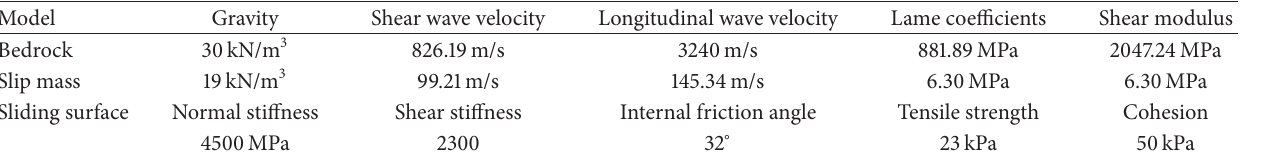
Table 1: Physical and mechanics parameters of bedrock, soil layer, and structural plane.